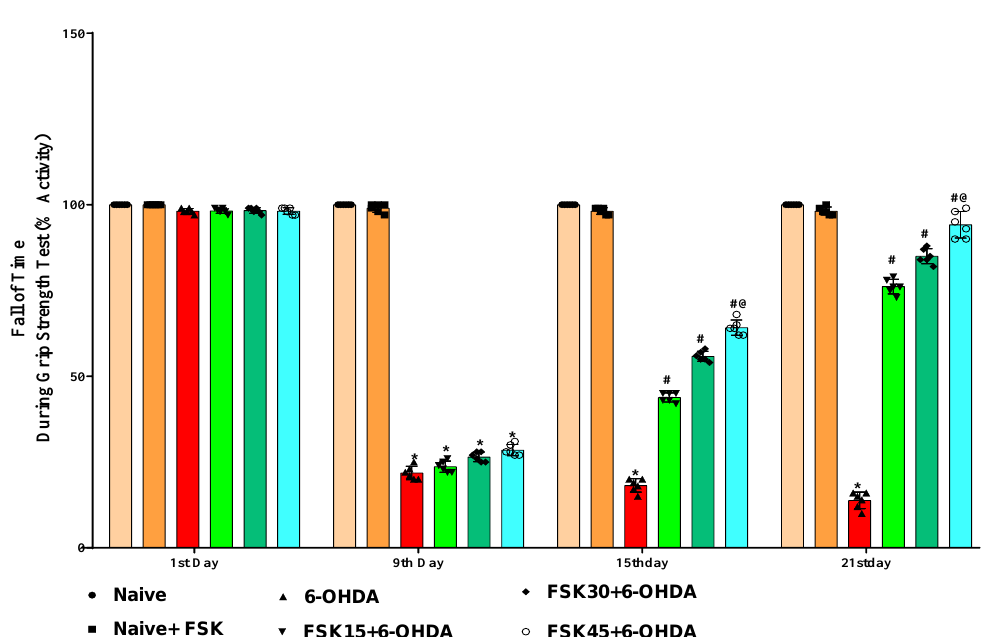
Molecules 2022 , 27 , x FOR PEER REVIEW 6 of 41